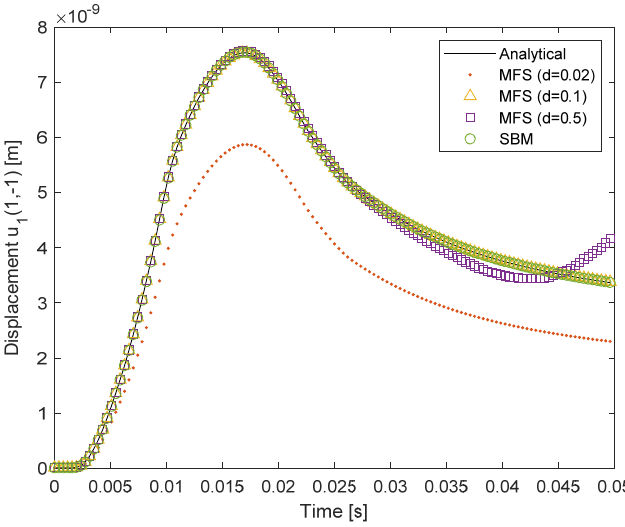
Figure 9. Numerical comparison between the MFS and SBM.